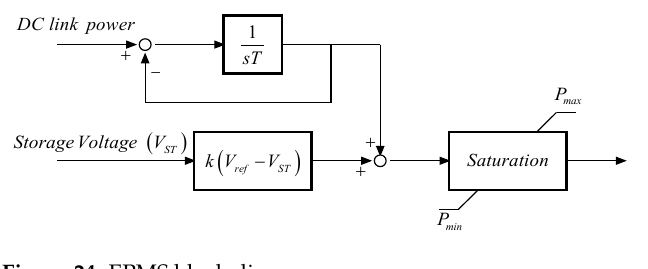
Figure 24. EPMS block diagram.